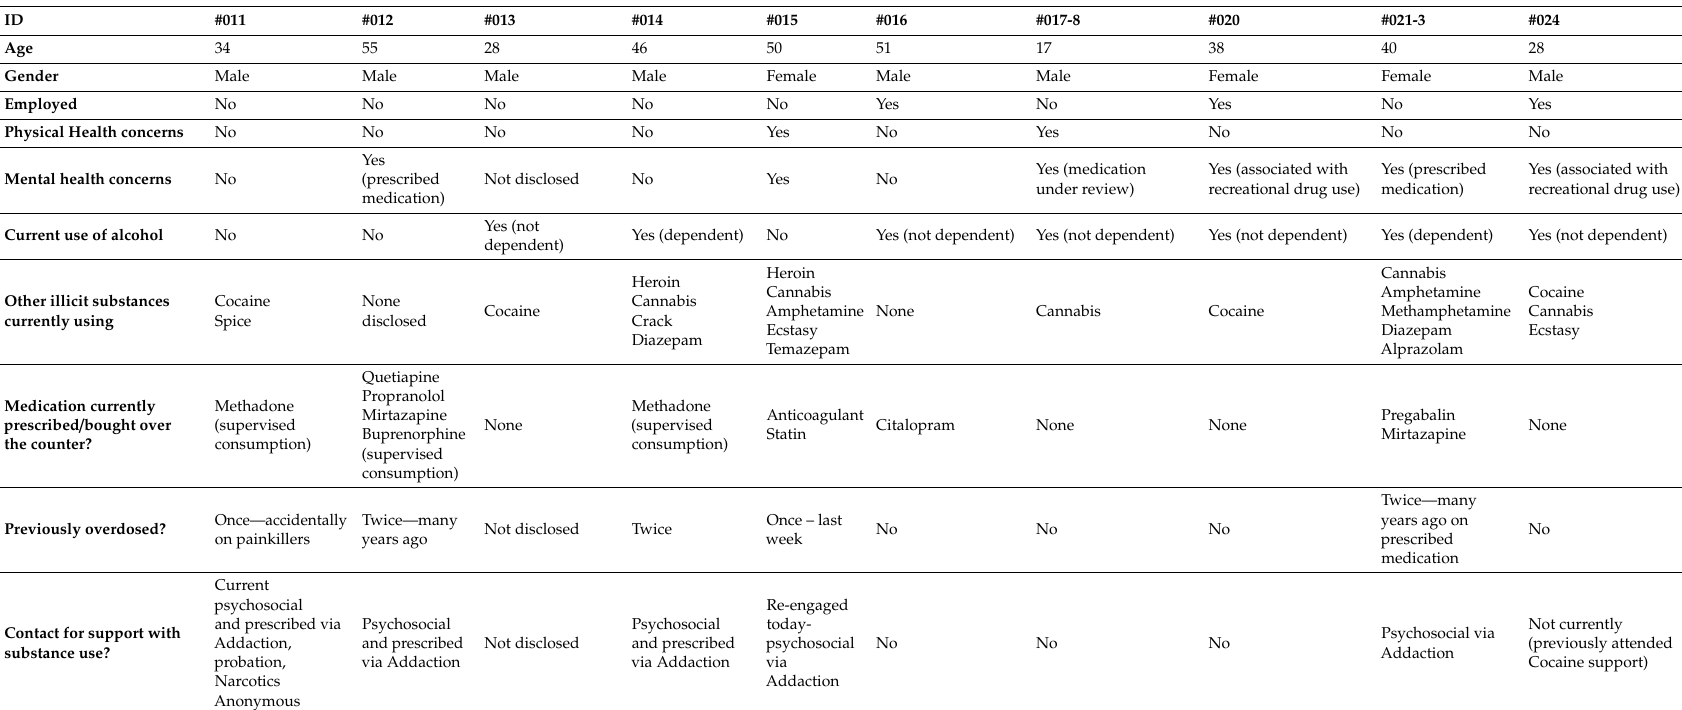
Table 1. Summary of questionnaire